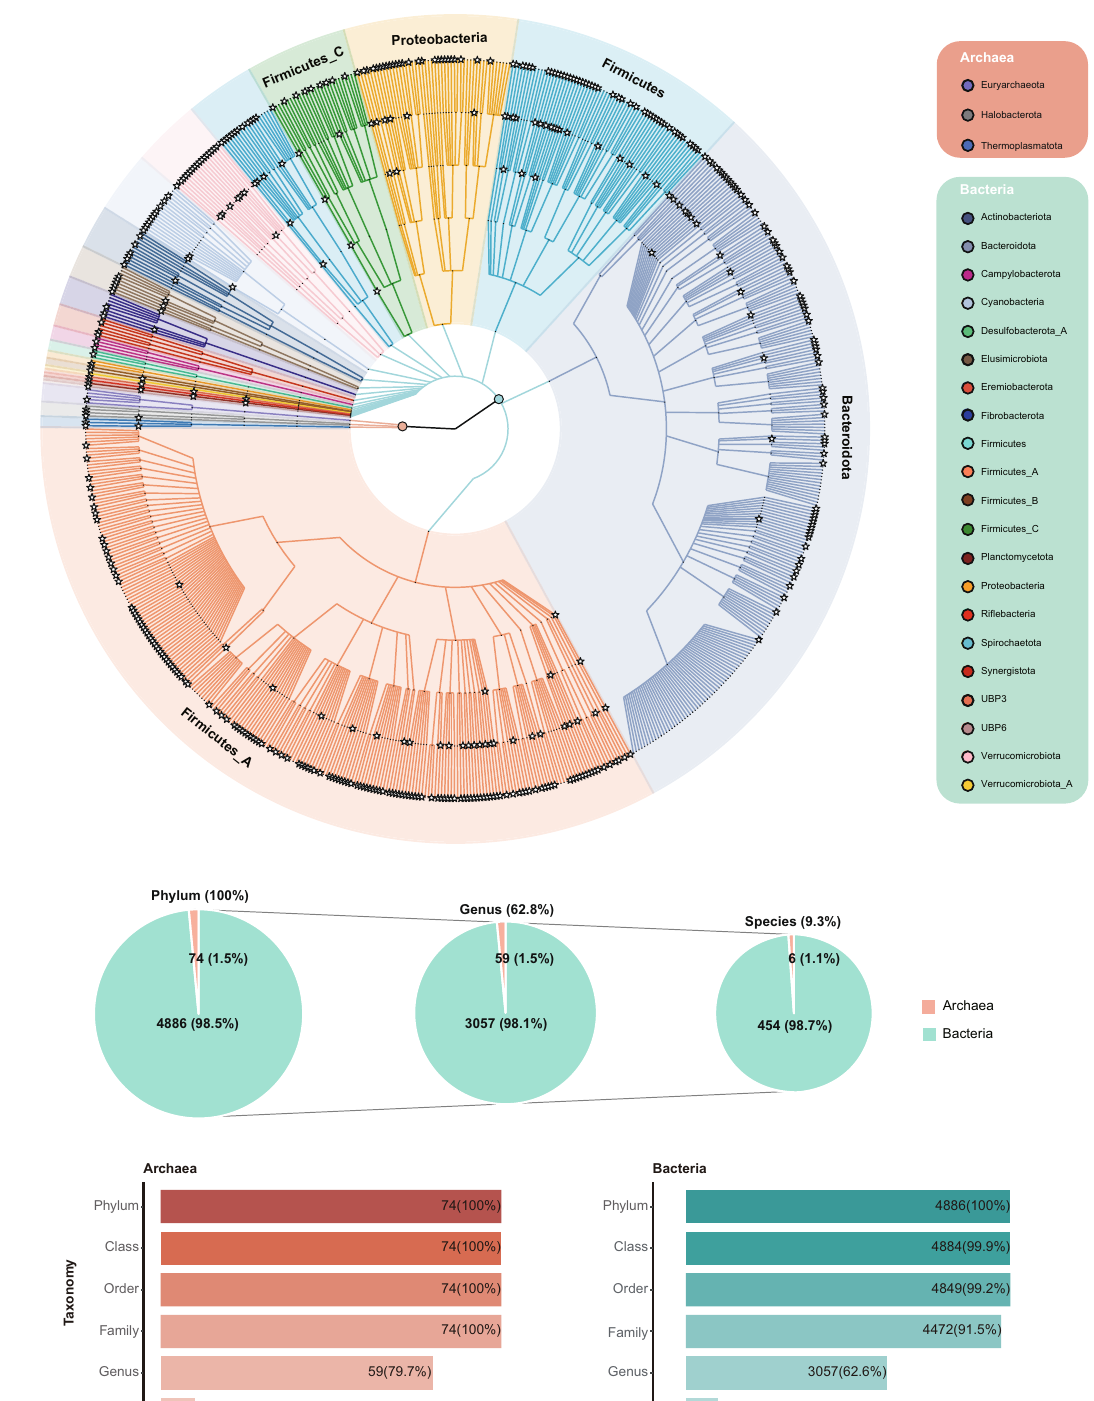
Taxonomic characteristics of MAGs in different sections along the digestive tract . To investigate the distributions of the 4960 MAGs in different sections along with the DT and their putative interactions with the host, we fi rst determined the coverage and relative abundances of all the MAGs in each sample. We mapped the clean reads of a sample to all MAGs and calculated the coverage of a MAG as the total aligned bases divided by the total